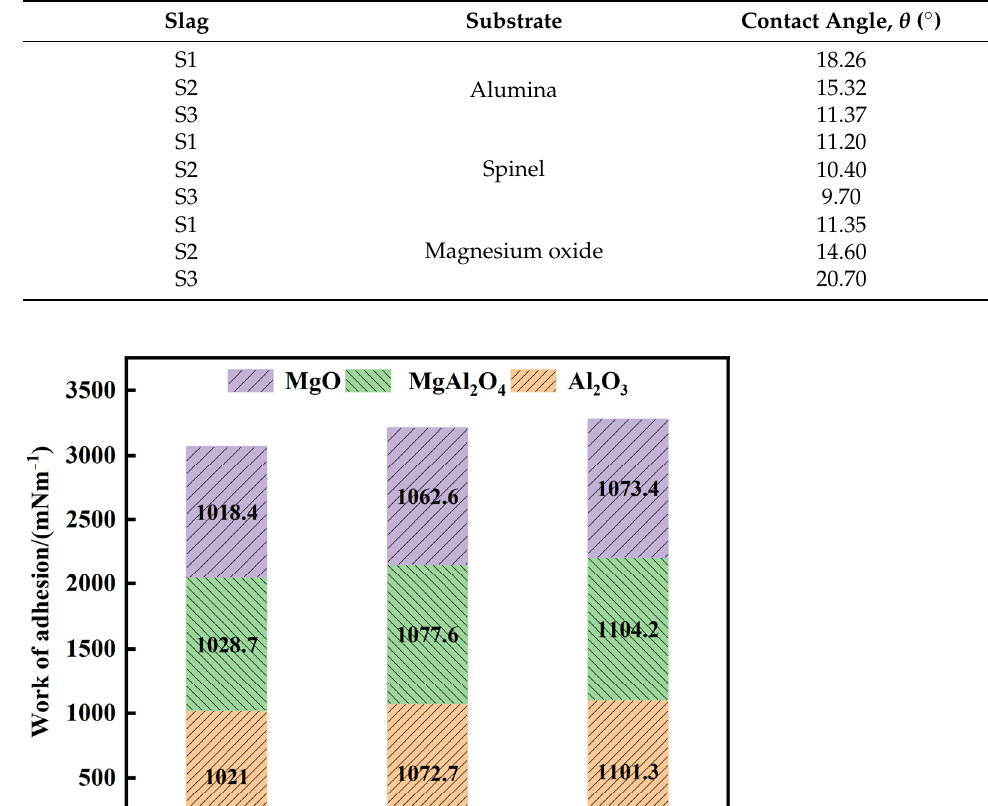
Table 6. Contact angles between various substrates and slags at 1600 °C.